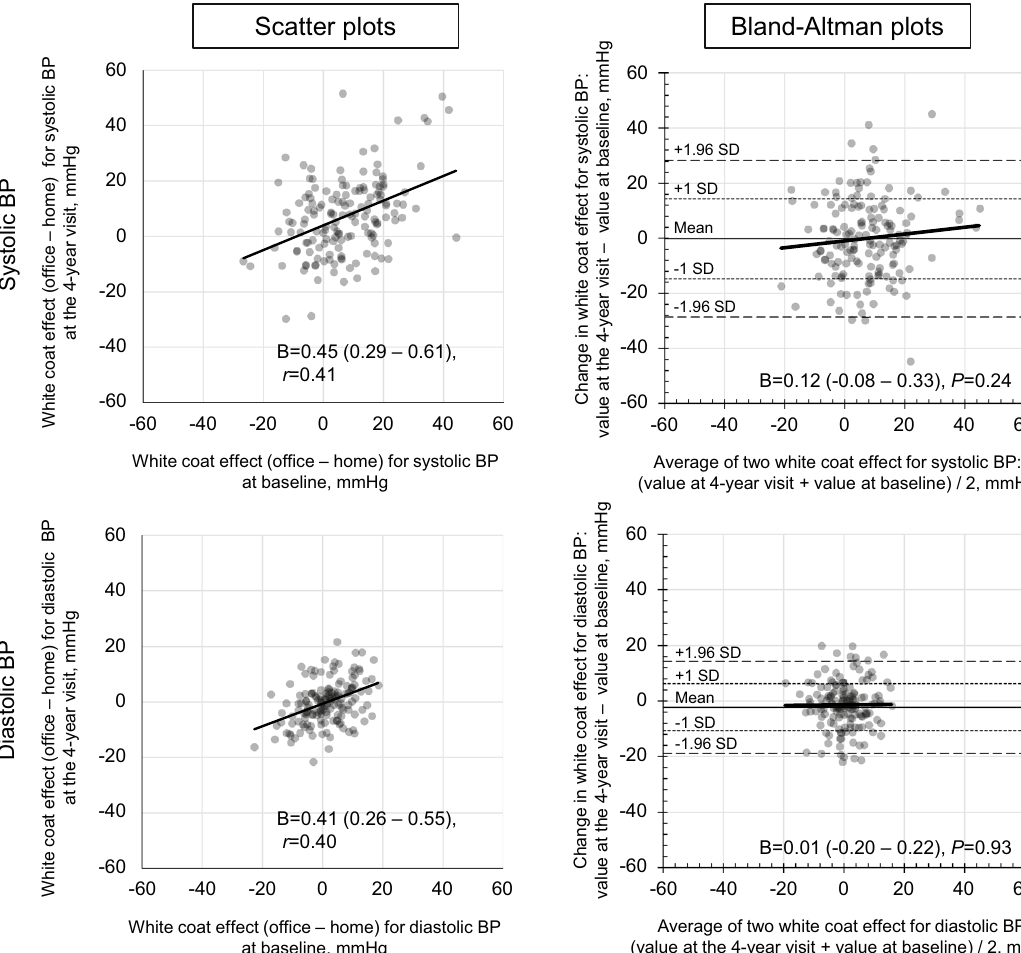
Figure 2. Scatterplots and Bland–Altman plots between the white-coat effect at baseline and the 4-year visit. “Β” and “r” refer to the regression coefficient (95% confidence interval) and Pearson’s correlation coefficient, respectively. BP blood pressure